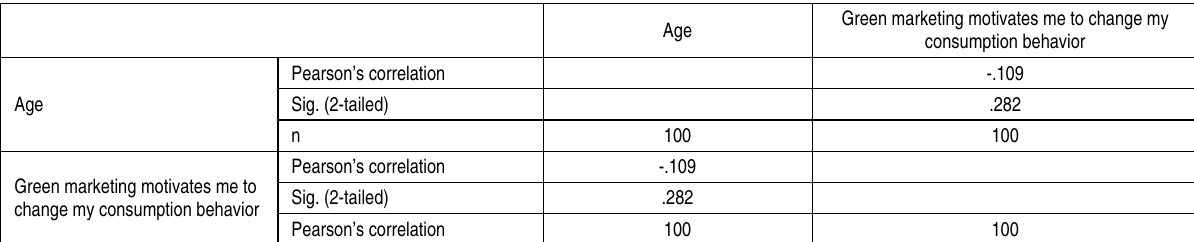
Table 4. Correlation between age and motivation to change consumption behavior